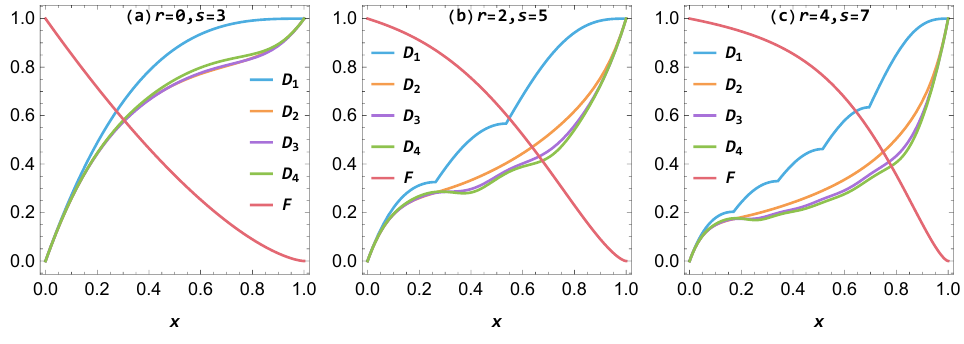
( ρ ) with n = A,k r , ρ A,k s n ) (5.41) in the free bosonic A,k r , ρ A,k s